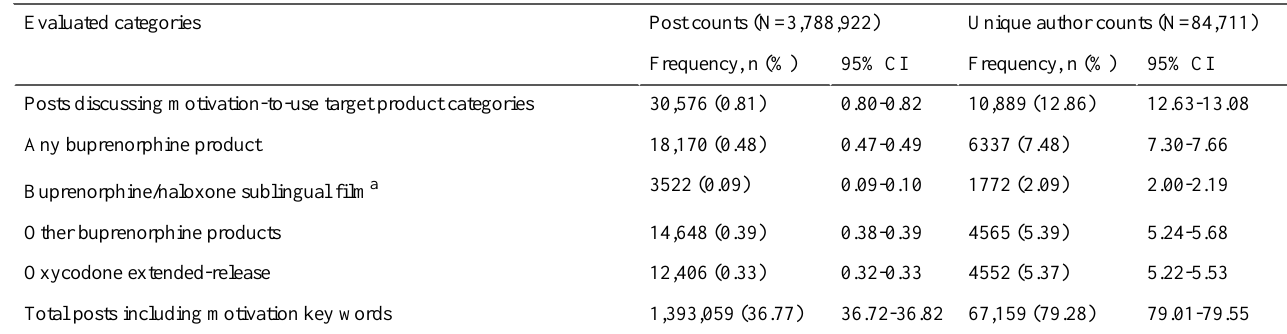
Table 3. Post and author counts of evaluated product categories (between January 1, 2012, and December 31, 2016).